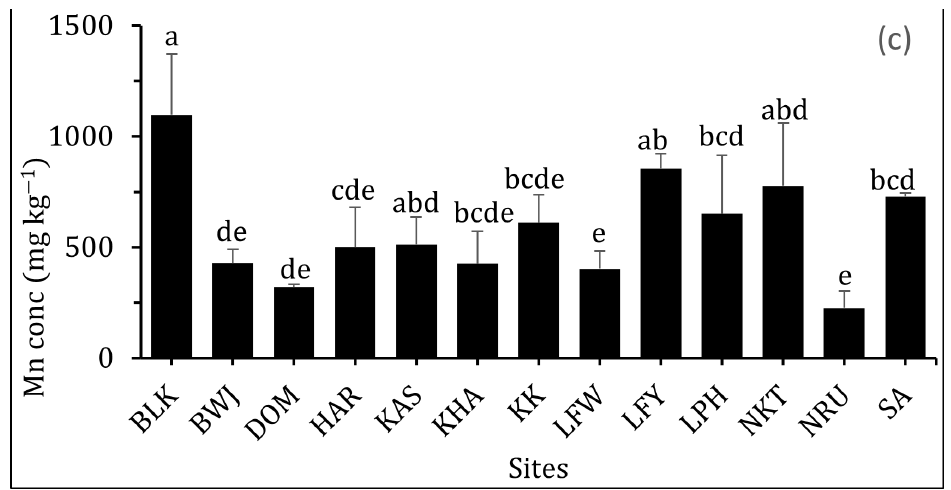
Figure 4. Metal(loids) concentrations in soils of paddy fields of various sites showing ( a ) Cr, ( b ) Co, and ( c ) Mn concentrations evaluated by site. BLK: Balaka (17), BWJ: Bwanje (15 and 16), DOM: Do- masi (18), HAR: Hara (3), KAS: Kasinthula (20), KHA: Khanda (19 and 19b), LFY; Lufiliya (1 and 2), LFW: Lifuwu (11), LPH: Limphasa (5 and 6), NKH: Nkhate (21 and 22), KK: Nkhotakota (7–9), NRU: North Rumphi (4), and SA: Salima (10, 12–14). Bars that share common letters (a, b, c, d and e) are not significantly different from each other.